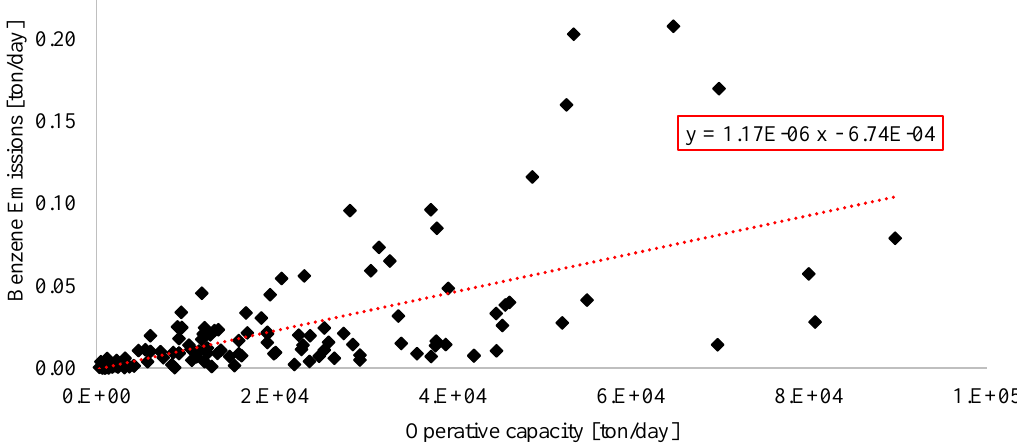
Figure 3. Total emissions of benzene for 119 refineries.